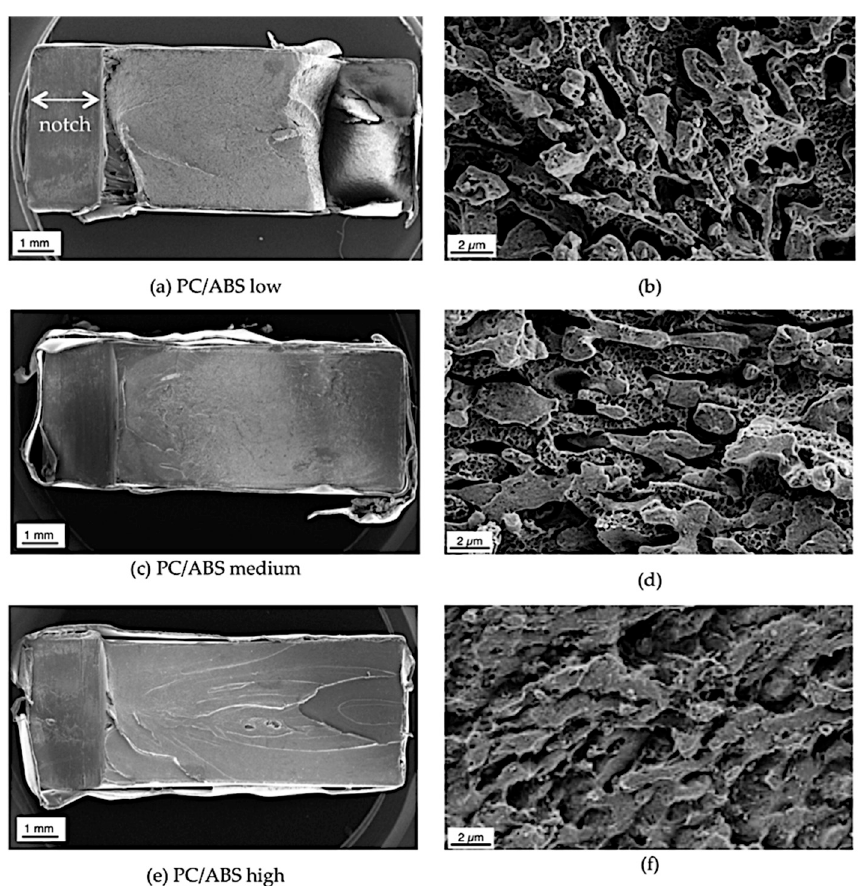
Figure 15. SEM micrographs of fracture surfaces of PC/ABS blends after Izod impact testing at − 30 °C: Blends based on ( a , b ) SAN low; ( c , d ) SAN medium; and ( e , f ) SAN high. The notch with a length of around 1.5 mm can be seen on the left side of the SEM pictures taken at the lower magnification.